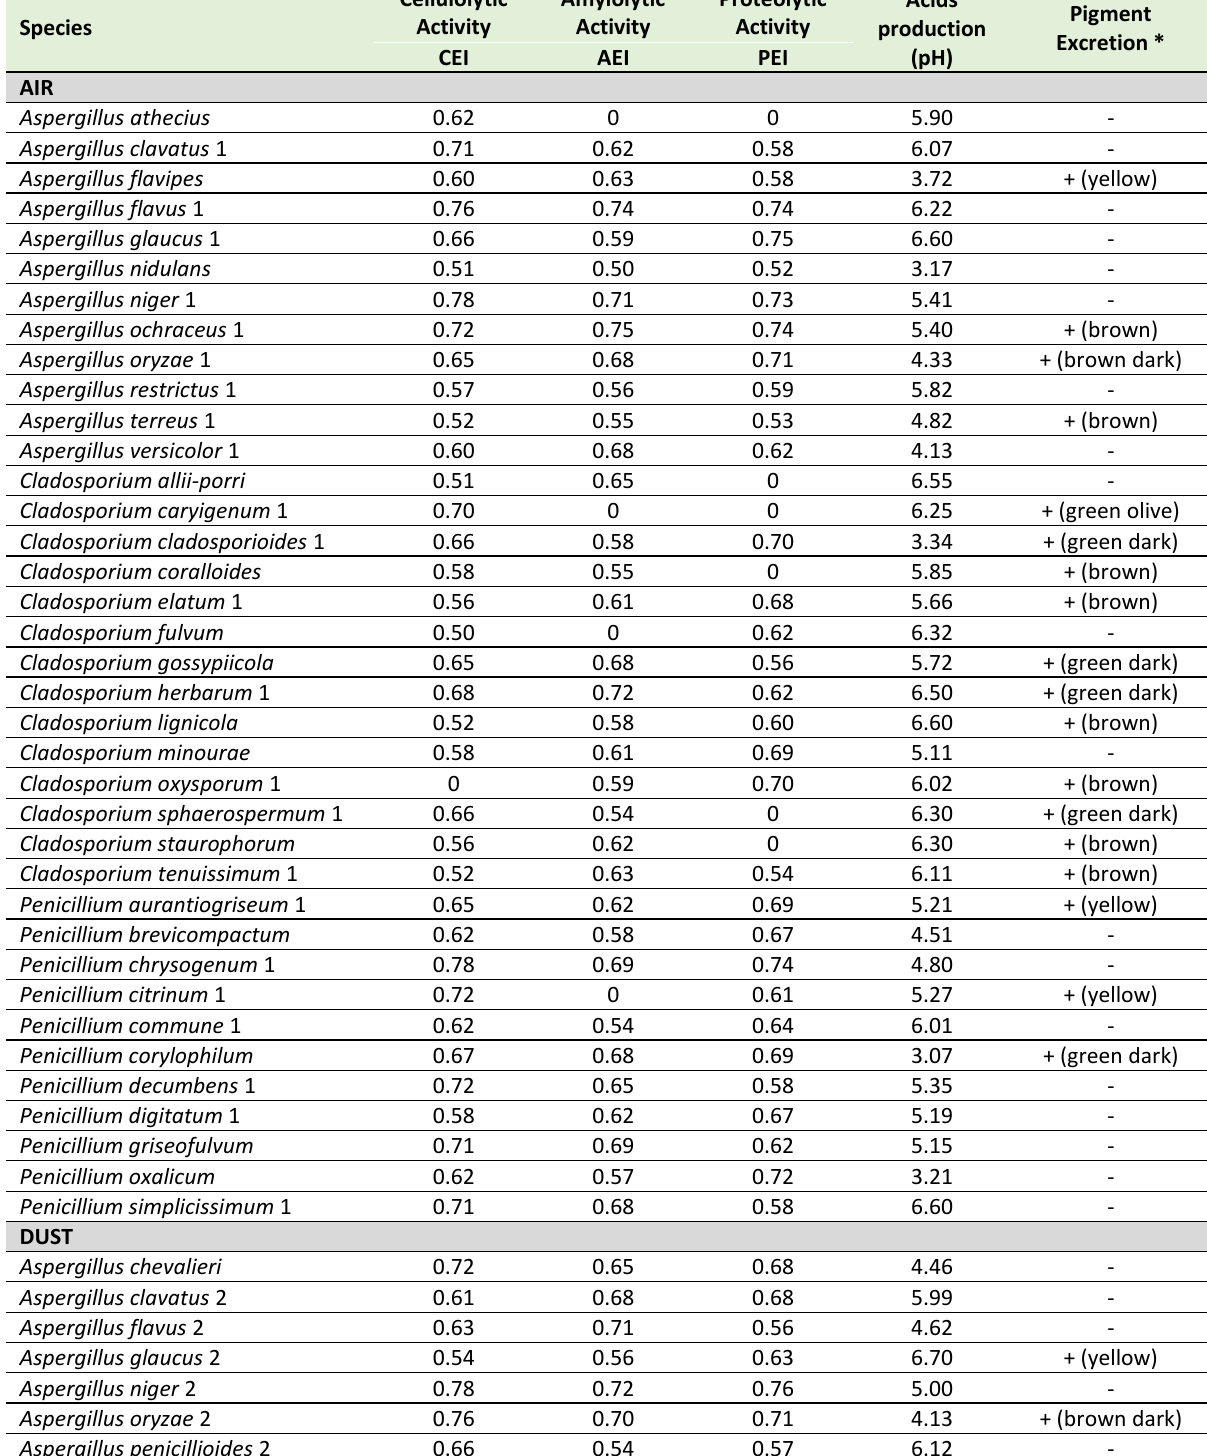
TABLE 6. Enzyme Index (EI) obtained of Aspergillus , Cladosporium and Penicillium strains isolated from the indoor air and collected dust from NARC